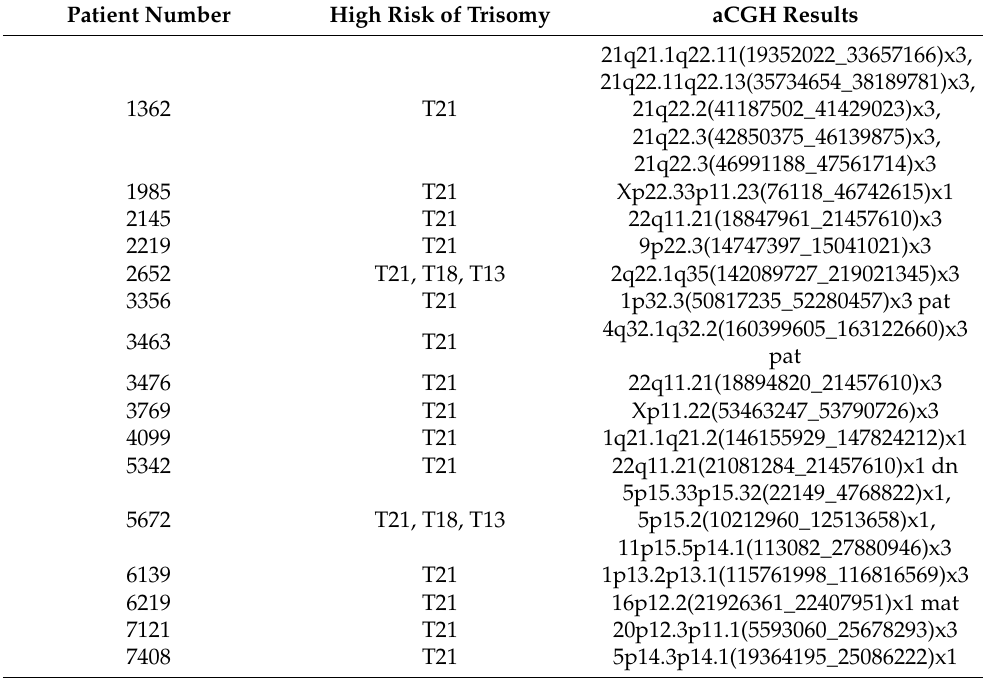
Table 5. 22 structural aberrations detected in group of 713 samples with abnormal result on PAPP-A test and normal